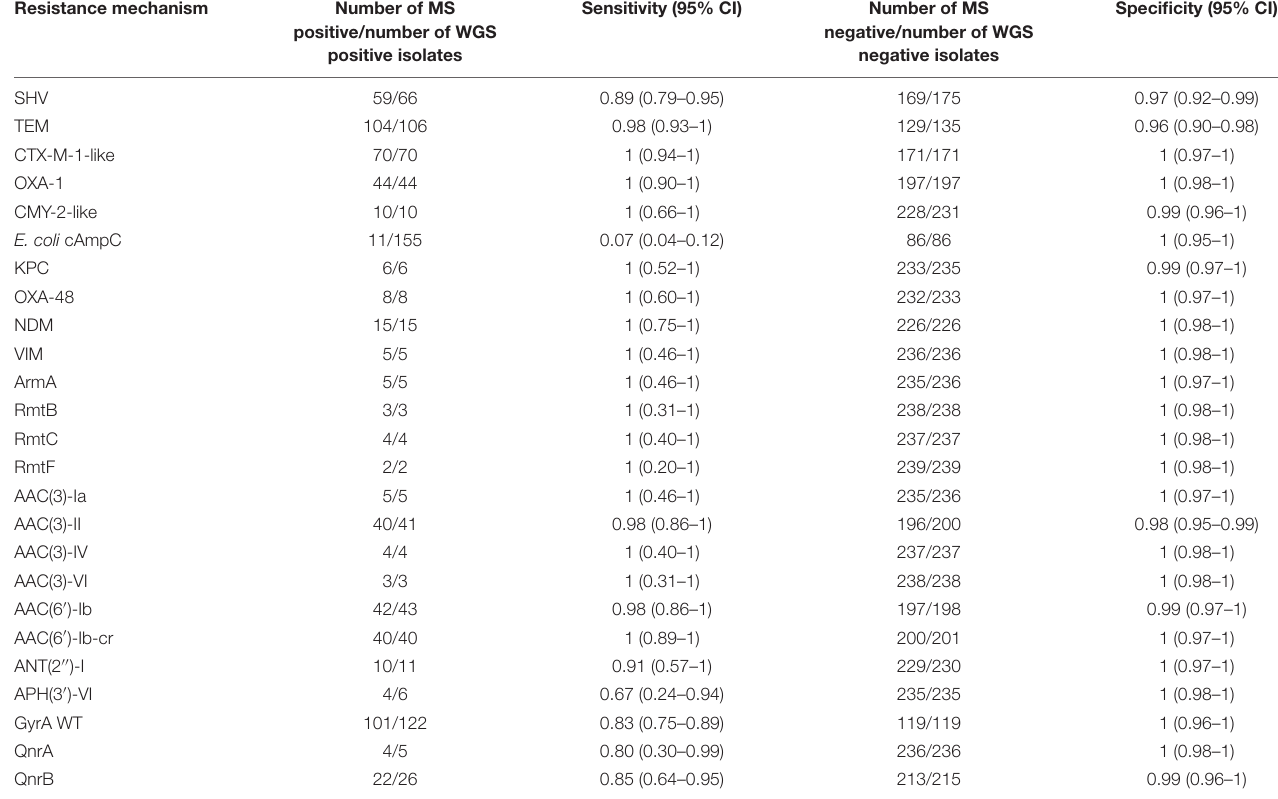
TABLE 3 | Sensitivity and specificity of LC-MS/MS compared to WGS in detecting the selected resistance mechanisms in 241 isolates. Resistance